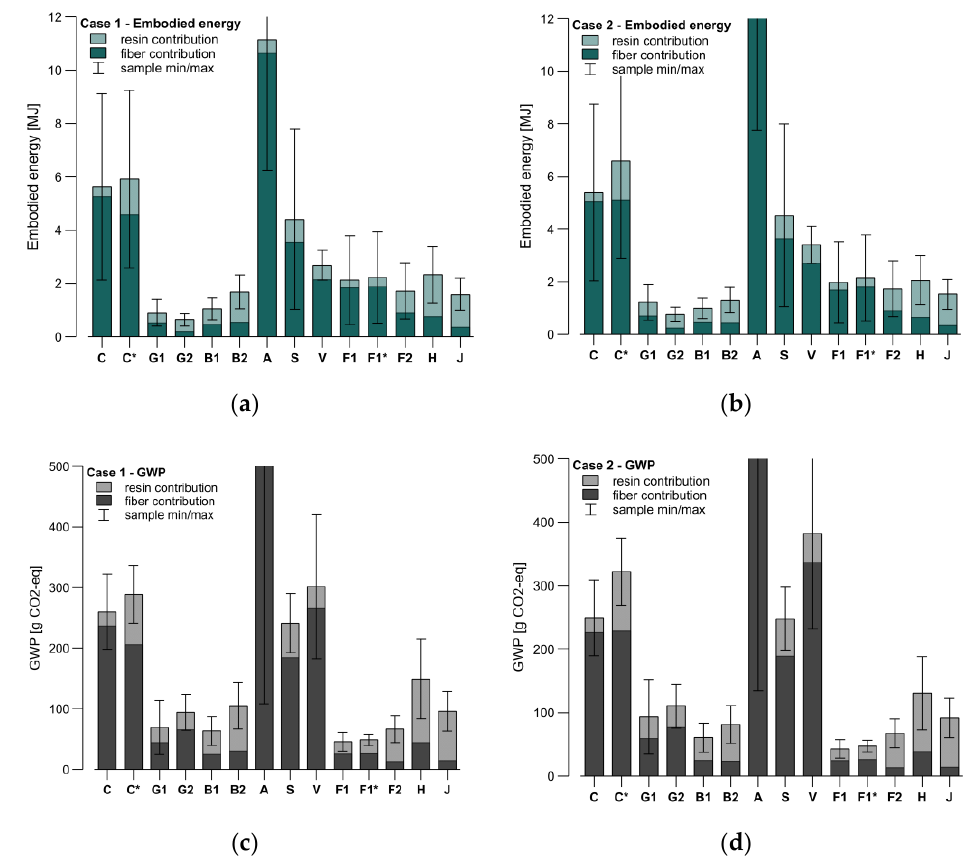
Figure 16. Sustainability assessment for theoretically equal-performance samples, Case 1 (strength) or Case 2 (stiffness) as per Figure 15. The contribution of the resin is stacked on top of the fiber contribution. Whiskers represent the samples’ deviations covering their full min/max range. C —